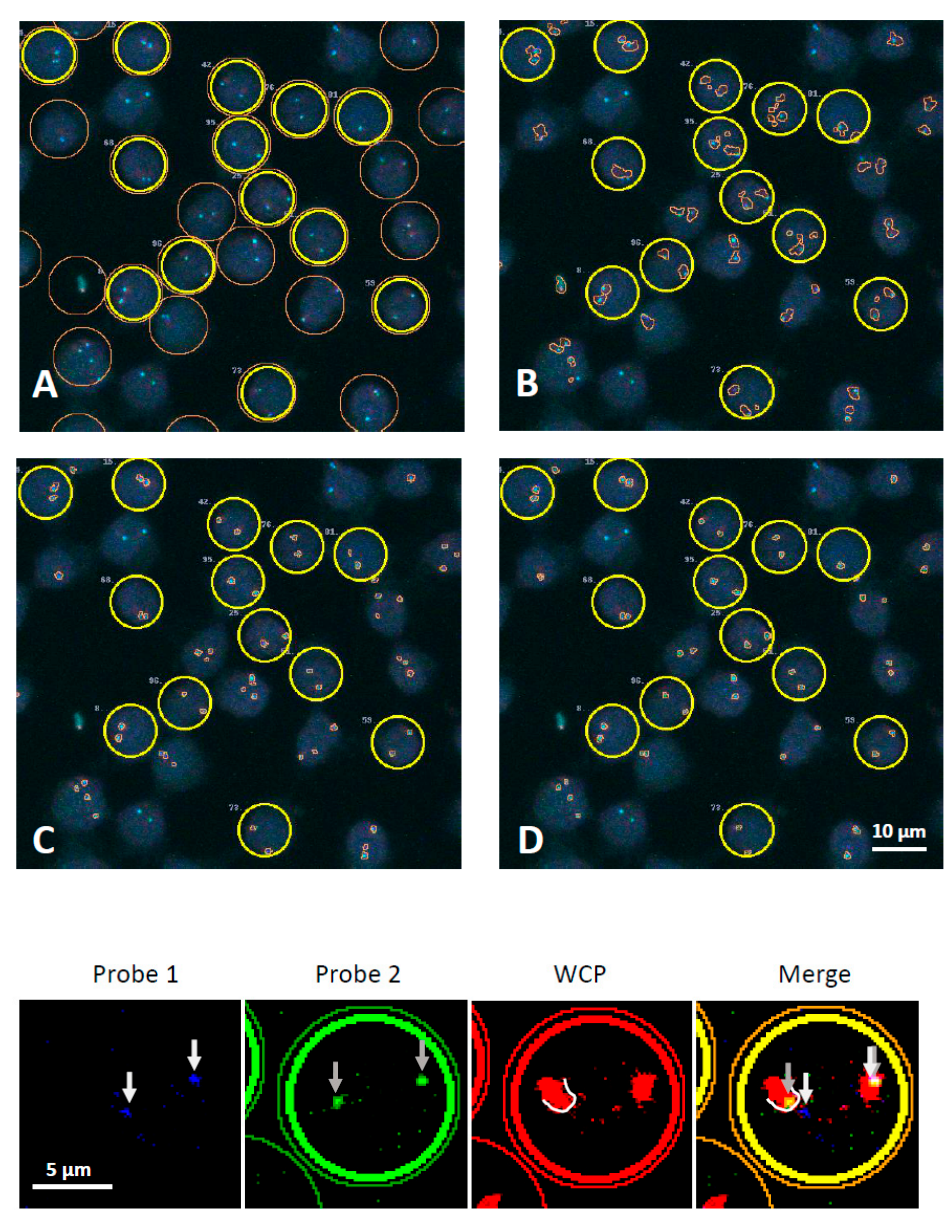
Figure 1. Example of program recognition of nuclei borders ( A ), chromosome territories ( B ), and upstream and downstream regions of the AML1 gene ( C , D ). Merged images from 3 channels are shown. Bold circles indicate the cells used for analysis (which passed all quality filters). The lower panels show an example of a cell with a “broken” AML1 allele (marked with arrows), one region of which is located outside the chromosomal territory visualized by a far-red whole chromosome painting probe (WCP). Probe 1 and probe 2 visualize upstream and downstream regions of the AML1 gene (Figure S1B).